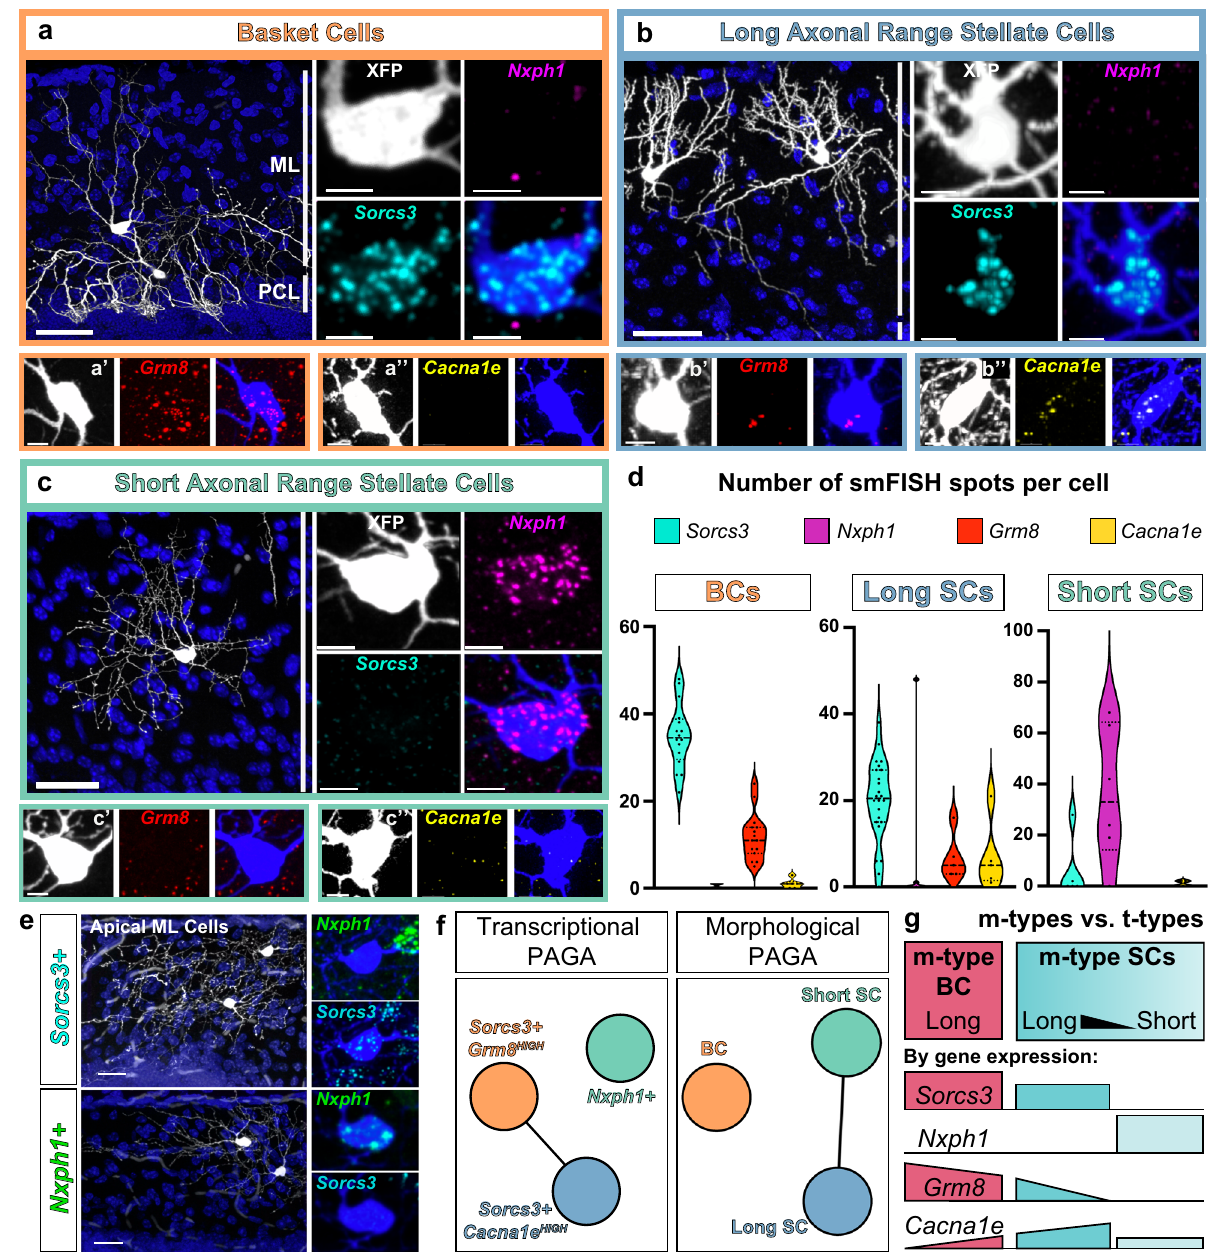
Fig. 5 Morphologically de fi ned MLI types do not align with transcriptionally de fi ned signatures but can be described by marker combinations. a – c morFISH co-staining of single fl uorescently-labeled MLIs with smFISH for t-type markers Sorcs3, Nxph1, Grm8 , or Cacna1e . Each panel (i.e. a , a ′ , a ″ ) shows three MLI soma from separate morFISH co-stainings. a m-type basket cell expresses Sorcs3 but not Nxph1 , and expresses high Grm8 and low Cacna1e ( a ′ , a ″ ). b m-type stellate cells with long-range axons express Sorcs3 but not Nxph1 , and express Cacna1e and lower Grm8 ( b ′ , b ″ ). c m-type stellate cells with short-range axons express Nxph1 and lower Sorcs3; Grm8 is absent but low levels of Cacna1e are detected ( c ′ , c ″ ). d Violin plot summarizing smFISH puncta quanti fi cations for markers within morphologically de fi ned BCs (left, n = 16 cells), long-range SCs (middle, n = 24 cells), and short-range SCs (right, n = 5 cells). Note the Sorcs3 + ; Grm8 HIGH ; Cacna1e LOW pattern among the BCs, the Sorcs3 + ; Grm8 LOW ; Cacna1e HIGH among m-type long SCs, and the exclusion of Grm8 in short-range SCs ( c ′ ). e SCs with long-range axons in the upper ML are either Sorcs3 + or Nxph1 + . Images and quanti fi cations from a – e are from four animals. f Comparison of MLI transcriptional and morphological identities, as assessed through PAGA. By transcriptional signatures, continuous heterogeneity is present between long-range BCs (orange) and SCs (blue), while short-range SCs (teal) are discretely separated from both transcriptional subtypes. By morphological signatures, there is a discrete division between BCs and SCs, with continuous heterogeneity spanning long- range and short-range SCs. g Schematic summarizes the expression patterns of t-type transcriptional markers among m-type MLIs. Scale bars are 35 µ m in a – d ; 20 µ m in e ; 5 µ m in inset, a ′ , a ″ – c ′ , c ″